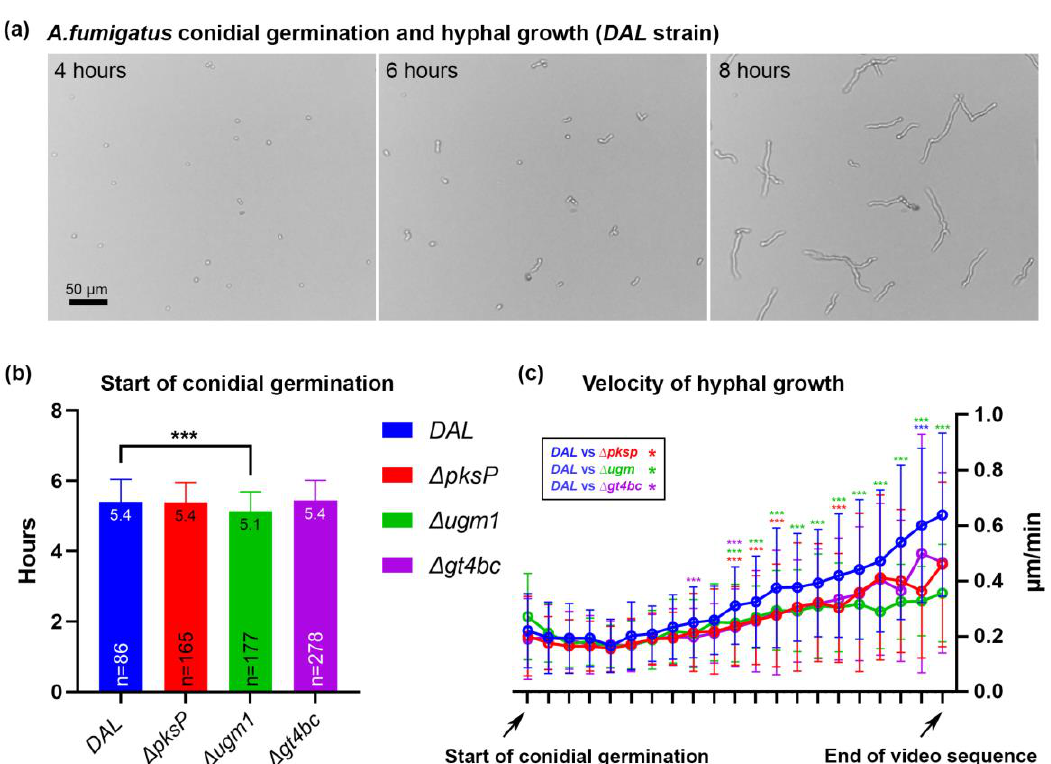
Figure 1. Conidial germination and dynamics of hyphal growth. ( a ) Frames of a live-video sequence show examples of hyphal growth after 4, 6 and 8 h of imaging; ( b ) starting point of conidial germination in four tested A. fumigatus strains. Depicted are mean ± SD of mean as a column, mean as value and number of quantified conidia, n; ( c ) velocity of hyphal growth. For graphical representation, all germinating conidia were plotted to the first tick of the x-axis with 10 min between data points. Each tick depicts velocity mean ± SD of mean in µm/min. In ( b , c ) significant differences ( p ≤ 0.001) between A. fumigatus strains are marked with *** according to the color scheme.